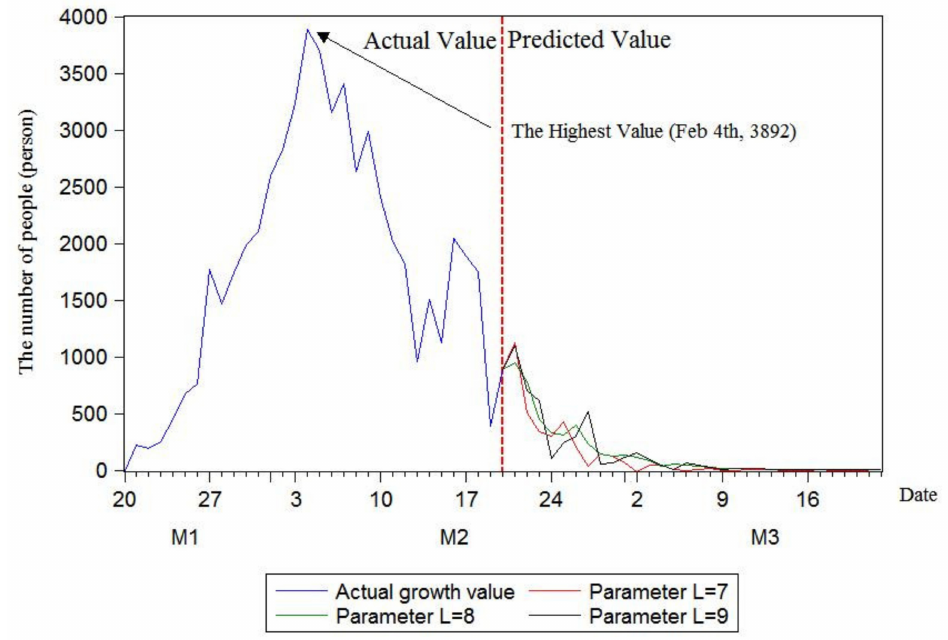
Figure 8. Changes in the daily growth of the number of confirmed patients in